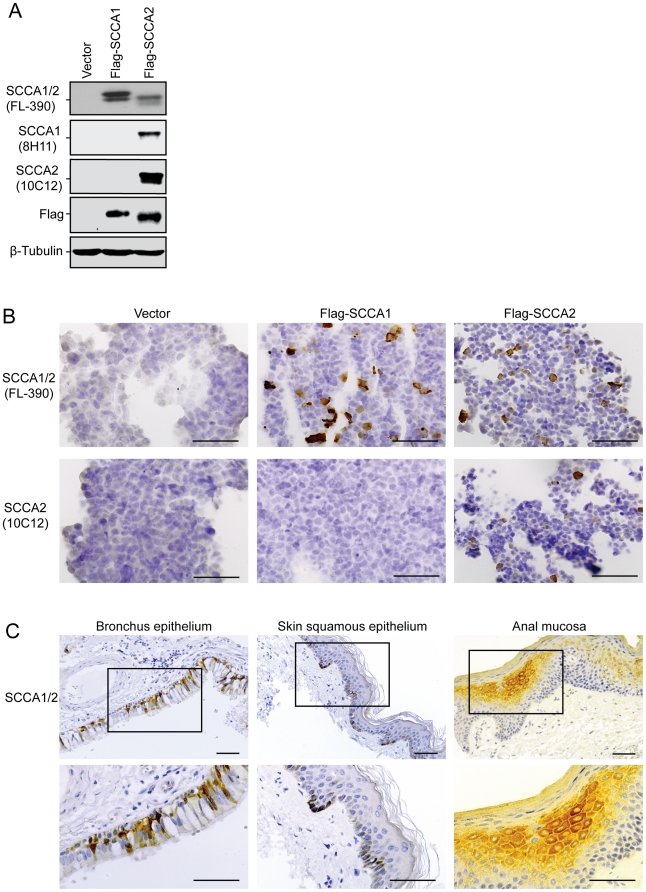
Validation of SCCA antibodies.293T cells were transfected with either vector alone, Flag-SCCA1, or Flag-SCCA2 plasmids. (A) Cells were subjected to immunoblot analysis using three SCCA antibodies: FL-390 for SCCA1/2, 8H11 for SCCA1, and 10C12 for SCCA2, as well as Flag antibody and β-tubulin antibody. (B) Cells were fixed and embedded in paraffin. IHC was performed with FL-390 and 10C12 antibodies. (C) IHC was performed on normal human tissue using the antibody Clone FL-390. Scale bars  = 50 µm.